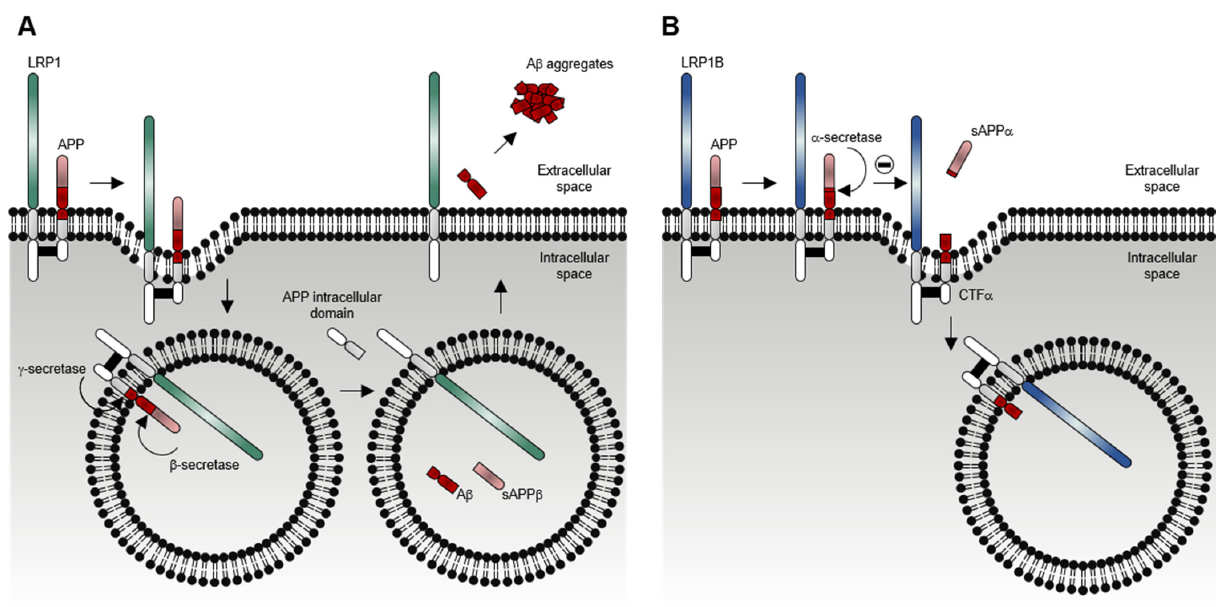
Figure 6. Model depicting the differential functions of LRP1 (A) and LRP1B (B) in endocytosis of APP. ( A ) The fast endocytosis of LRP1 enhances APP endocytosis and, therefore, promotes the proteolytic processing of APP through the amyloidogenic pathway. Once delivered to the endosomes, APP is firstly cleaved by a β -secretase, producing a soluble β -cleaved APP fragment (sAPP- β ) and a carboxyl-terminal β fragment (CTF- β ). This fragment is further cleaved by a γ -secretase, producing the highly toxic amyloid β -peptide (A β ) and the APP intracellular domain. Most of the A β peptides are secreted to the extracellular space, where they can rapidly aggregate and form fibrils that deposit into the amyloid plaques (which are associated with the progression of Alzheimer’s disease). ( B ) The slow endocytosis of LRP1B decreases APP endocytosis and, therefore, promotes the proteolytic processing of APP through the non-amyloidogenic pathway. At the cell surface, APP is firstly cleaved by an α -secretase, producing a soluble α -cleaved APP fragment (sAPP- α ) and a carboxyl-terminal α fragment (CTF- α ). This fragment can be further cleaved by a γ -secretase, producing the non-toxic peptide P3 and the APP intracellular domain.